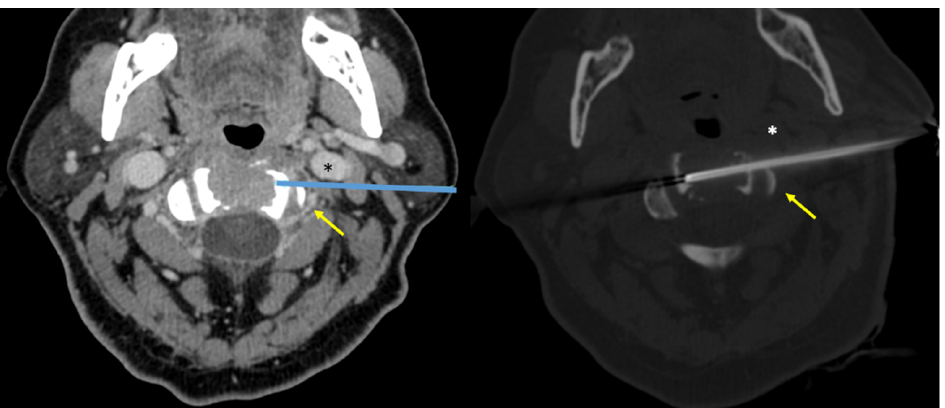
Figure 4. A 64-year-old woman. Preliminary CT scan with intravenous contrast injection, axial view ( Left ), allowed for planning the biopsy approach ( Right ). Vital vascular structures can be visualized: left vertebral artery (arrows) and left jugular vein (asterisks). The biopsy allowed obtaining the histopathological diagnosis as multiple myeloma.